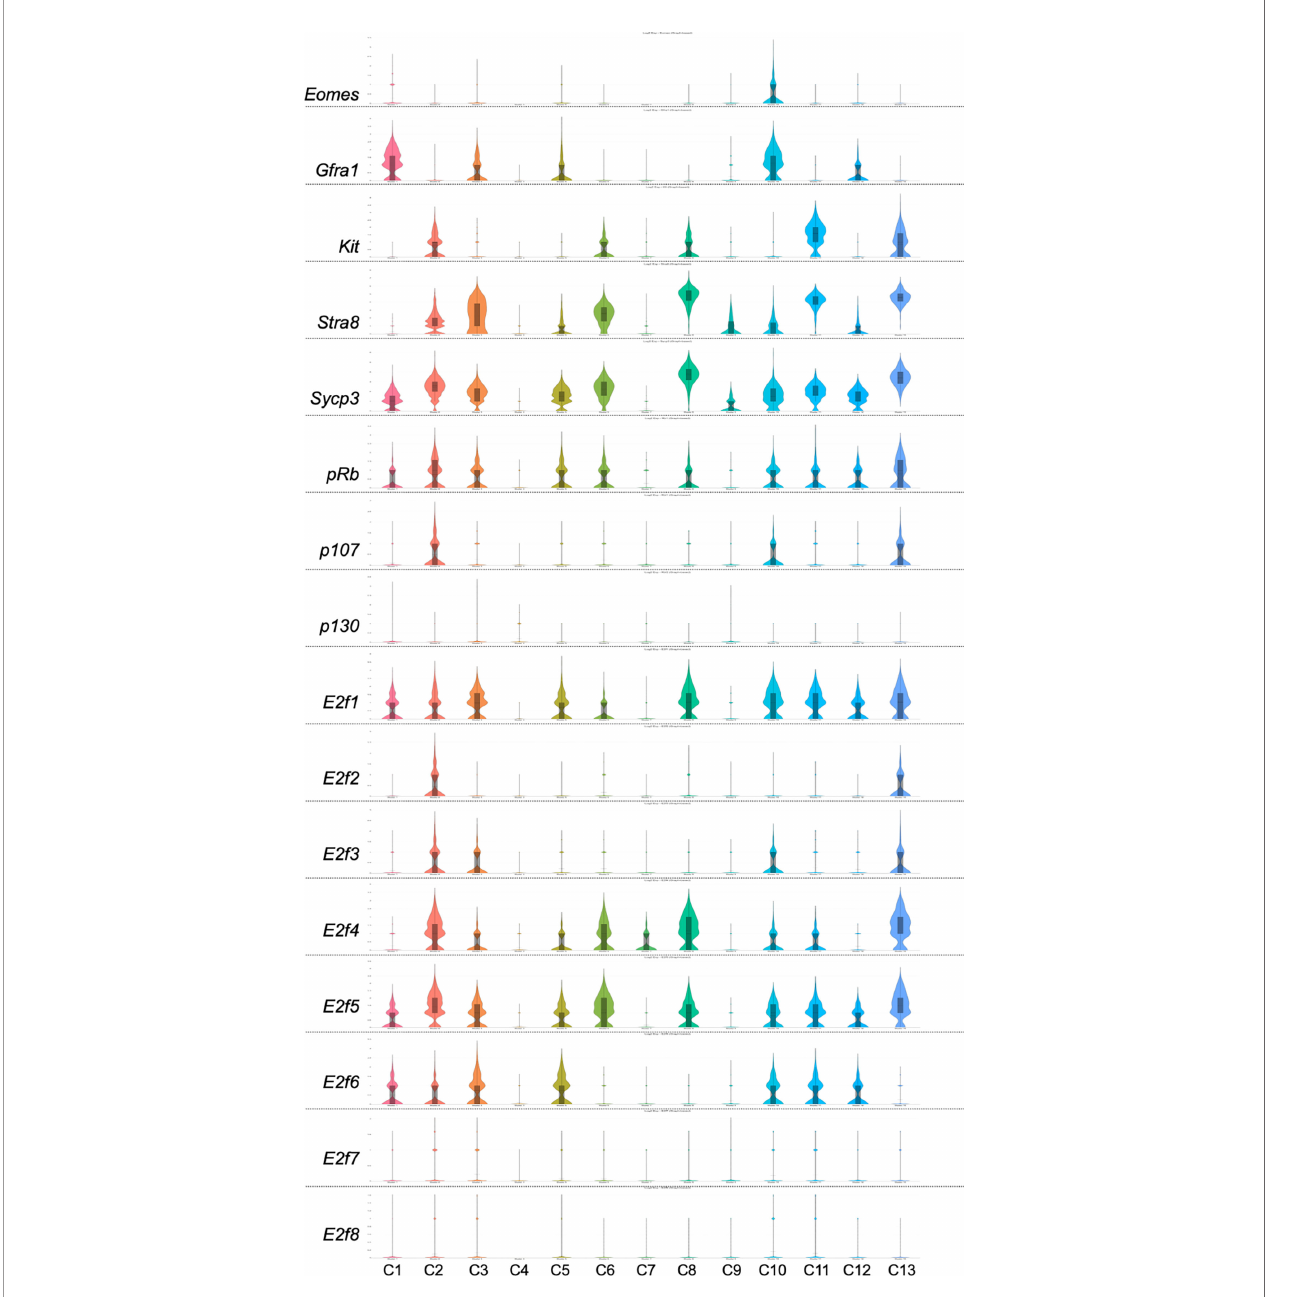
FIGURE 3 | Violin plots displaying the expression of Eomes, Gfra1, Kit, Stra8, Sycp3, pRb, p107, p130 and E2f1-E2f8 in spermatogonial cells of an adult mouse. The data is extracted from Hermann et al. 2018 (26) using Loupe Cell Browser v6.0.0 from 10x Genomics. Spermatogonia are divided into clusters 1-13